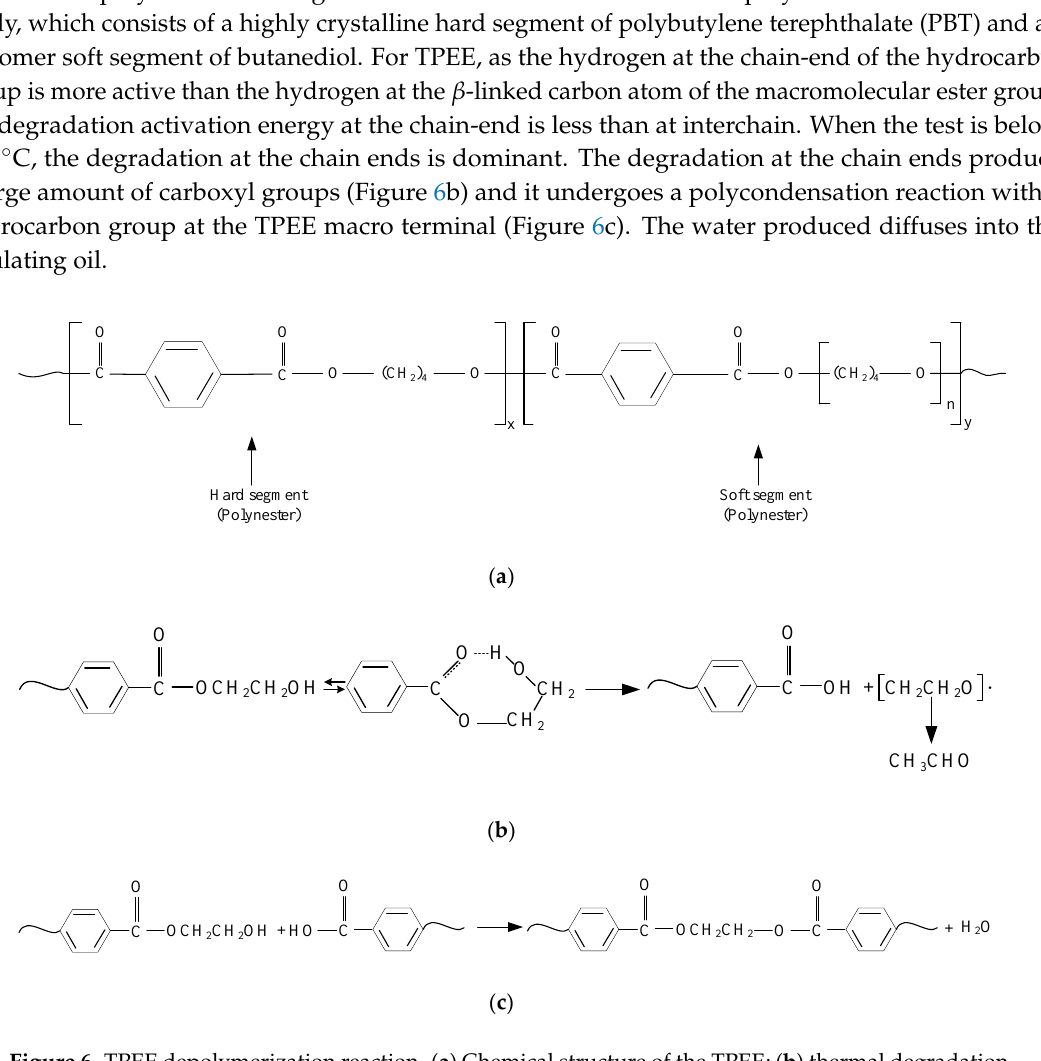
Figure 6. TPEE depolymerization reaction. ( a ) Chemical structure of the TPEE; ( b ) thermal degradation at chain ends; and (c) polycondensation.